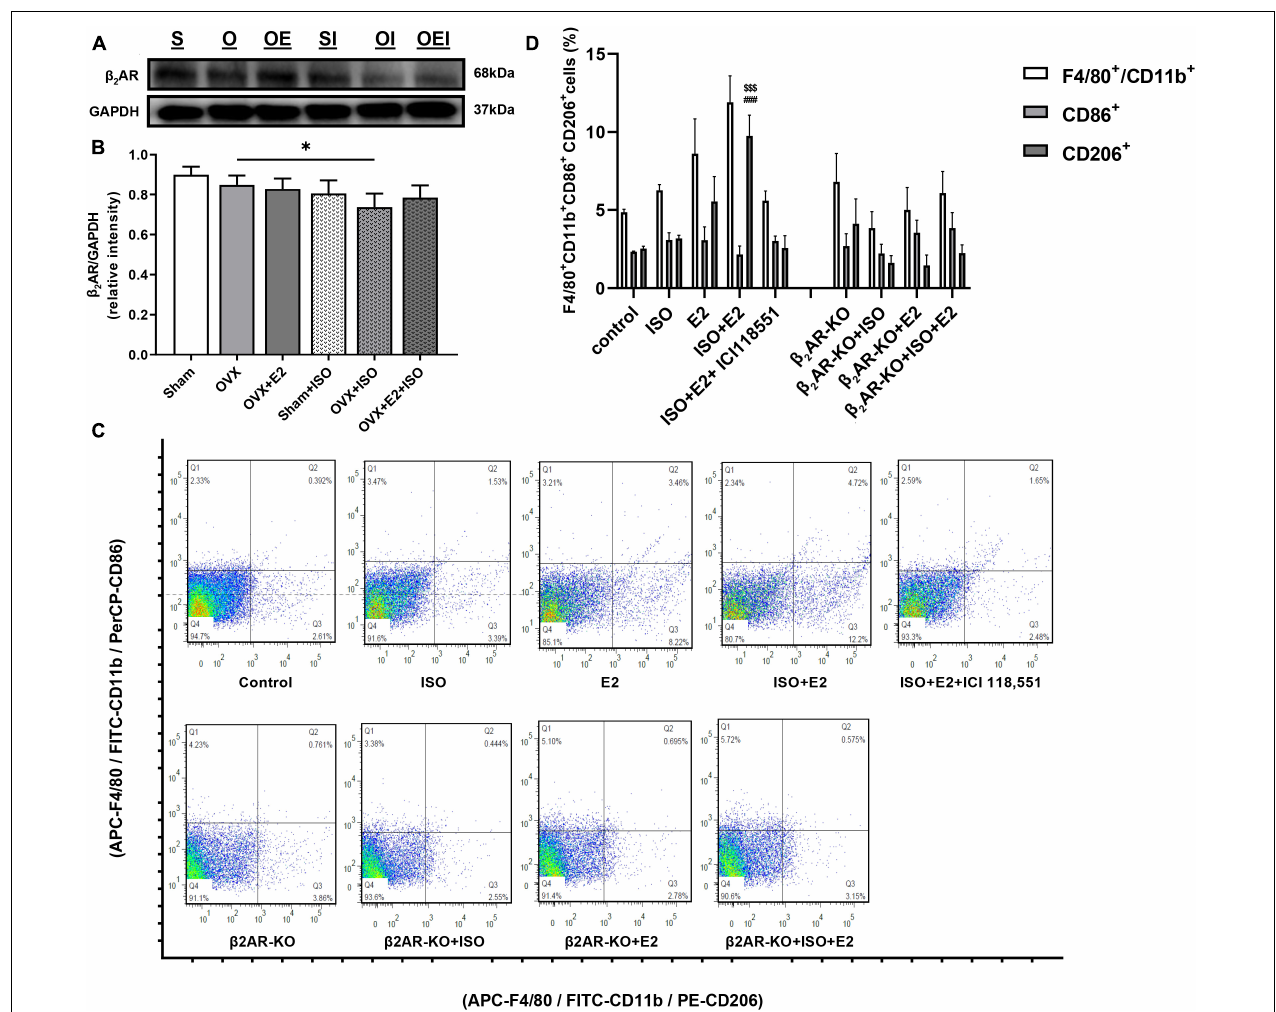
FIGURE 5 | Estrogenic adaptive immunoregulation of macrophage polarization involves modulation of β 2 AR signaling activities. (A,B) Representative immunoblots and graphical presentation of β 2 AR expressions evaluated from the myocardia. S, Sham; O, OVX; OE, OVX + E 2 ; SI, Sham + ISO; OI, OVX + ISO; OEI, OVX + E 2 + ISO ( n = 4 hearts/group). (C,D) Representative flow cytometry plots of gated macrophage phenotypes and graphical presentation of their M1 and M2 expression ratios ( n ≤ 1 ∗ 10 6 cells). The phenotypic populations of macrophages were quantified using FlowJo. ∗ p < 0.05; $$$ p < 0.001 vs. CD86+ (ISO + E2); ### p < 0.001 vs. CD206+ (ISO + E2 + ICI118551). Data are presented as mean ± SEM. Data were analyzed using two-way ANOVA, followed by Sidak’s post hoc